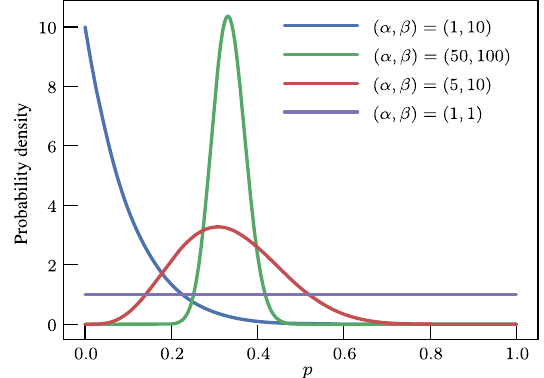
FIG. 17. Beta distributions for the noise magnitudes p and q allow us to control the degree of prior knowledge we have on their values. For example, the values ð α ; β Þ ¼ ð 1 ; 10 Þ represent an expectation that the value of p is relatively low, with a mode at 0 and average α = ð α þ β Þ ¼ 1 = 11 ≈ 0 . 09 . The values ð α ; β Þ ¼ ð 50 ; 100 Þ express the relative certainty that the value of p is close to 1 = 3 , whereas the values ð α ; β Þ ¼ ð 5 ; 10 Þ represent the same average expectation but with less certainty. The values ð α ; β Þ ¼ ð 1 ; 1 Þ express the largest amount of uncertainty about the parameter p , in which case it is uniformly distributed in unit